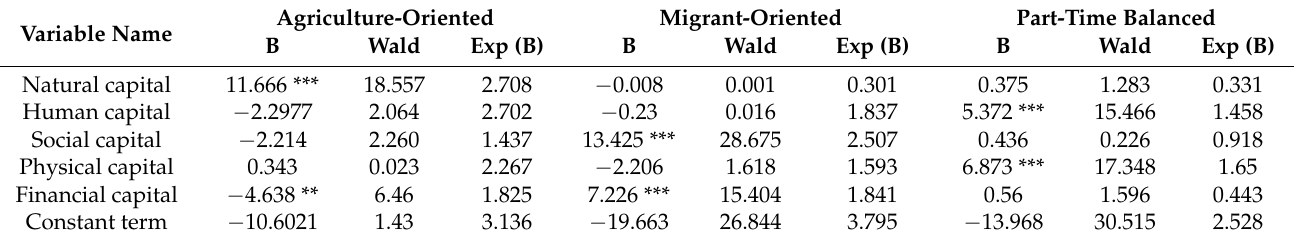
Table 6. Binary logistic regression analysis of the impact of livelihood capital on the livelihood